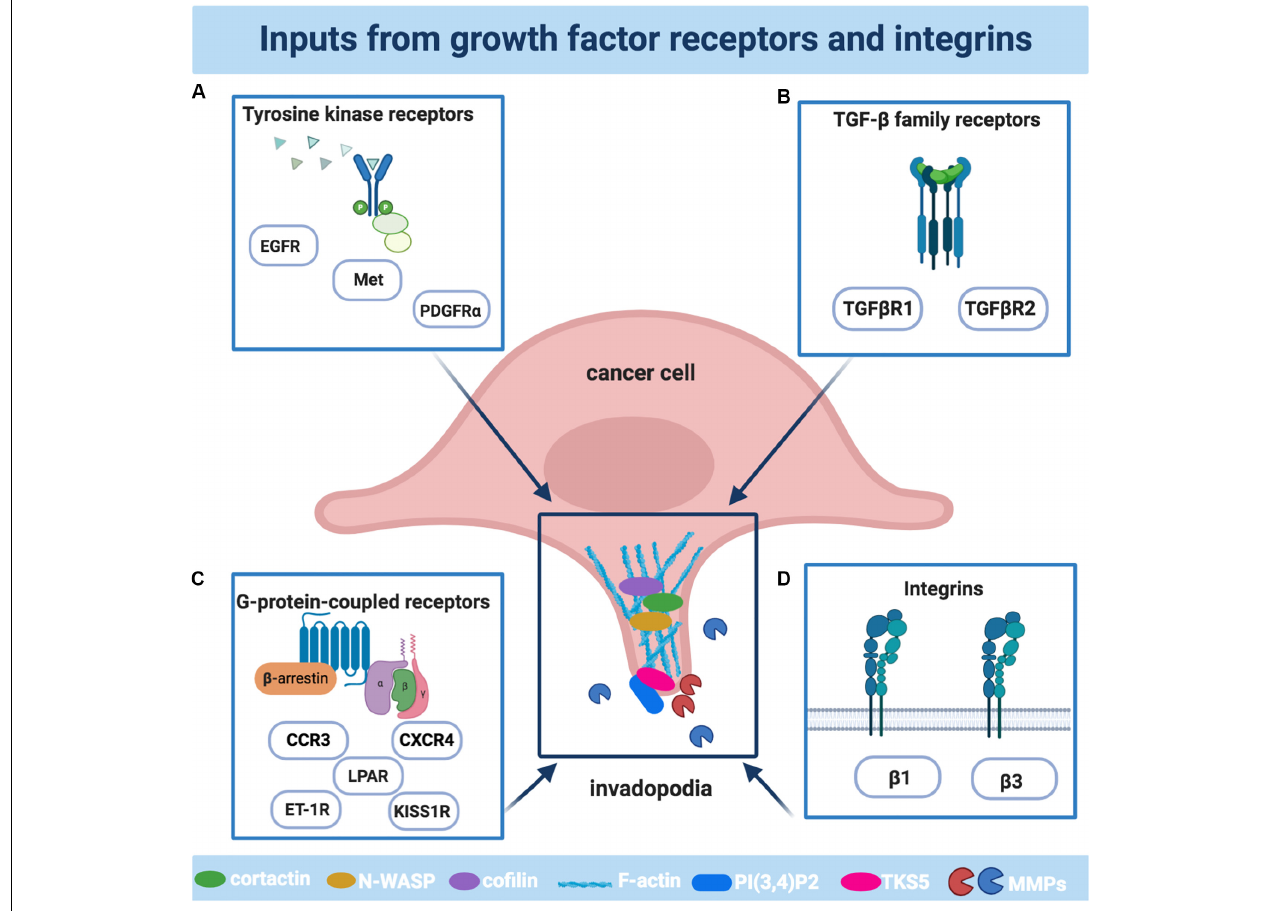
FIGURE 1 | The main receptors involved in the formation and activities of invadopodia. Schematic illustration of the main cellular receptors driving invadopodia in cancer cells: (A) The family of tyrosine kinase receptors includes epidermal growth factor receptor (EGFR), platelet-derived growth factor receptor α (PDGFR α ), Tyrosine-Protein Kinase Met (Met); (B) The family of G-protein-coupled receptors (GPCR) includes lysophosphatidic acid receptors (LPAR), endothelin-1 receptors (ET-1R), kisspeptin receptors (KISS1R), C-X-C Motif Chemokine Receptor 4 (CXCR4), C-C Motif Chemokine Receptor 3 (CCR3); (C) The transforming growth factor β (TGF β ) receptors family includes TGF β R1 and TGF β R2; (D) The family of integrins includes the β 1 and β 3 subunits. The plot was created using BioRender